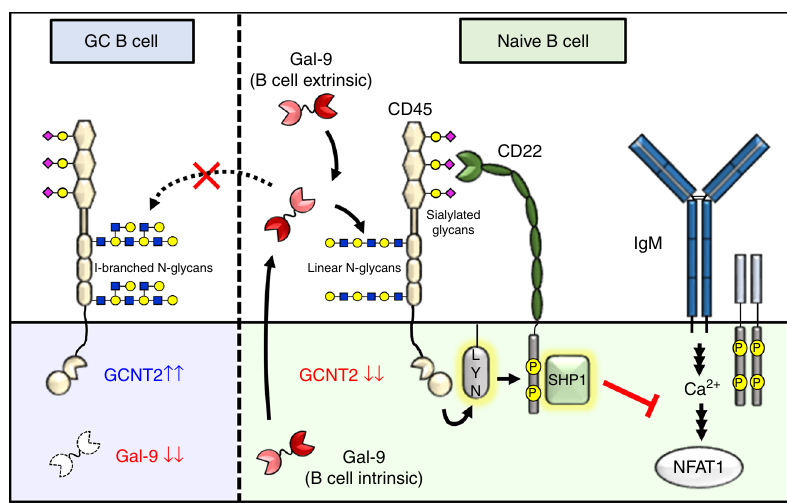
Fig. 8 Proposed role of Gal-9 and I-branches in the regulation of BCR signaling in naive B cells vs. GC B cells. In naive B cells (right), Gal-9 is expressed at high levels and secreted into the microenvironment by an unconventional mechanism. Autologously, or exogenously, produced Gal-9 binds poly-LacNAc- containing N-glycans on CD45, which are predominantly of the linear type due to low expression of the I-branching glycosyltransferase GCNT2. Gal-9 binding to CD45 activates Lyn (by an undetermined mechanism), which subsequently phosphorylates tyrosine residues in CD22 ITIMs and recruits the protein tyrosine phosphatase SHP-1. SHP-1 phosphatase activity dampens cytoplasmic calcium levels, including calcium accumulation in response to BCR engagement, possibly through its reported ability to activate B cell calcium ef fl ux pumps. Diminished intracellular calcium levels results in decreased nuclear translocation and activity of NFAT1 and other calcium sensitive signaling factors, ultimately inhibiting B cell activation. By contrast, Gal-9 activity is downmodulated in GC B cells (left) via the combined downregulation of Gal-9 protein and upregulation of GCNT2 , which disfavors Gal-9 binding by modifying N-glycan poly-LacNAcs with